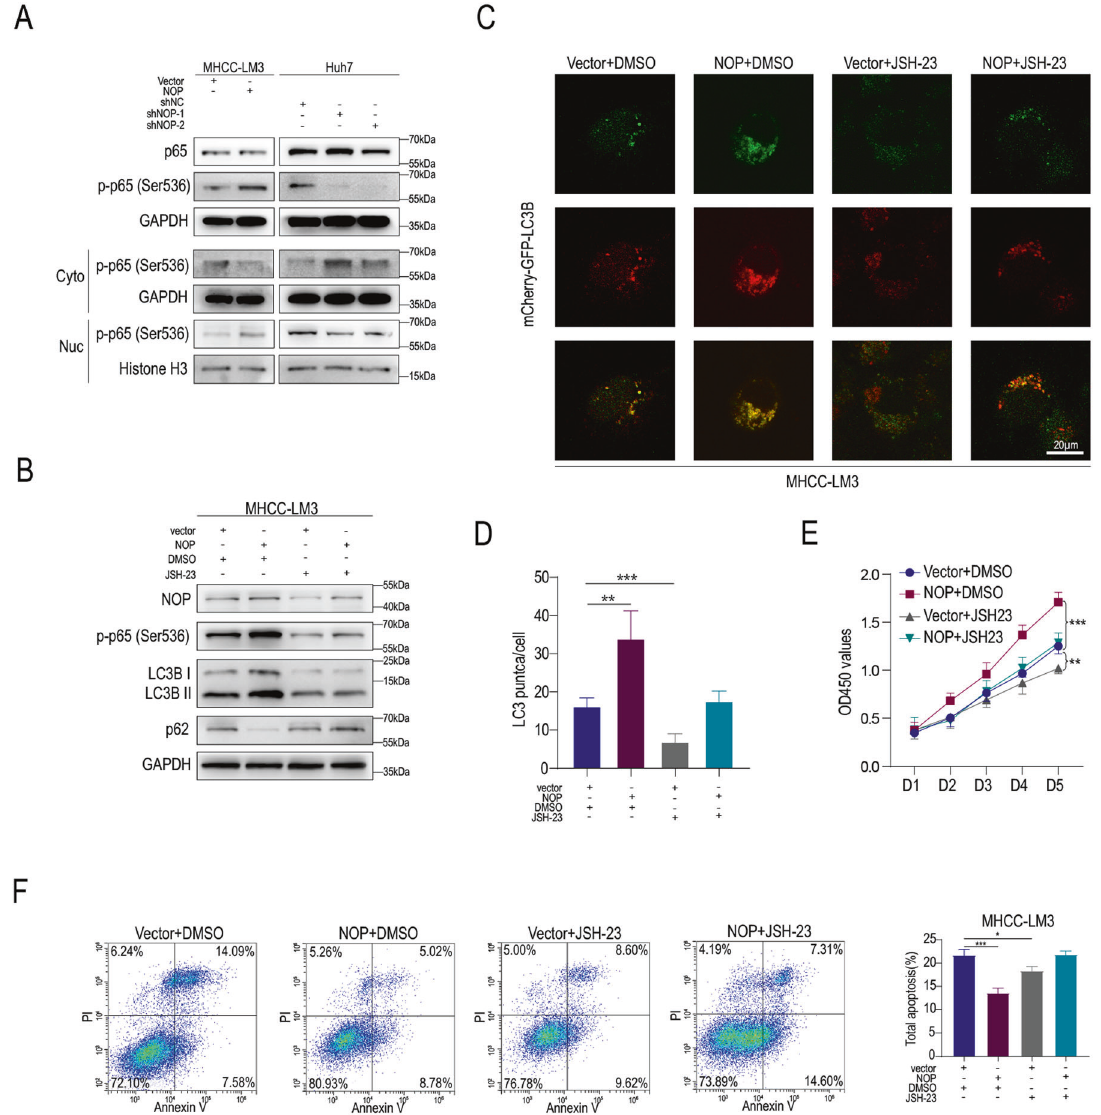
Fig. 4 NOP promotes autophagy by activating the NF-kB signaling pathway. A IB analysis of the indicated proteins associated with the NF-kB pathway in MHCC-LM3 and Huh7 cells. B IB analysis of the indicated proteins associated with the NF-kB pathway in MHCC-LM3 and Huh7 cells treated with JSH-23 or DMSO. C , D IF staining showing LM3 expression in MHCC-LM3-vector and MHCC-LM3-NOP HCC cells treated with JSH-23 or DMSO. Scale bars = 20 μ m. E CCK-8 assay showing the proliferation of MHCC-LM3-vector and MHCC-LM3-NOP HCC cells treated with JSH-23 or DMSO. F Apoptosis rates in MHCC-LM3-vector and MHCC-LM3-NOP HCC cells treated with JSH-23 or DMSO. *** P < 0.001, ** P < 0.01, * P <